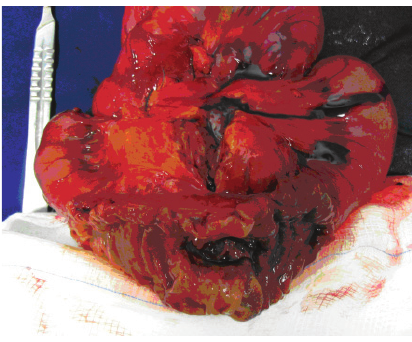
Figure 5 – Surgical specimen showing small intestinal lesion with invasion of the colon.